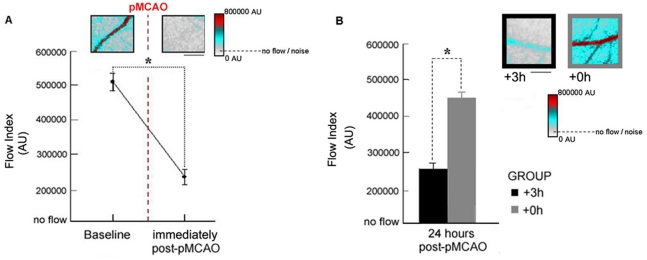
LSI experiments demonstrate that blood flow in MCA is re-established on the following day if whisker stimulation is administered immediately post-pMCAO.Insets, Representative linearly color scaled LSI images taken at (A) pre-pMCAO baseline and immediately post-pMCAO, or (B) 24 hours post-pMCAO for an animal from each of +0 h and +3 h groups. Scale bar indicates 0.25 mm. Graphs, the x-axis crosses the y at the mean noise level, or, ‘no flow’ level as determined by averaging values recorded from a group of euthanized animals (n = 6) at approximately 5 minutes after cessation of heart beat (MCA was thus no longer flowing in these animals hence the designation ‘no flow’ for equivalent values). To establish flow values in the absence of flow (noise) we collected data from a group of euthanized animals 5 minutes after the cessation of heart beat. We analyzed an MCA ROI as we had in live subjects and determined an average noise or ‘no-flow’ value (106,595±12,481SE). (A): Inset, note the large reduction in MCA flow. Graph, means and standard errors for MCA flow at pre-pMCAO baseline and immediately post-pMCAO. * indicates a significant difference between baseline and immediately post-pMCAO flow values (B): Inset, note the minimal blood flow apparent in the +3 h subject and the substantial blood flow in the +0 h subject despite the fact that the same double suture and complete transection of MCA's base was performed in both animals 24 hours prior. Graph, means and standard errors for MCA in +3 h and +0 h subjects 24 hours post-pMCAO. Note that the minimal flow values in +3 h group animals at 24 hours post-pMCAO are similar to levels seen immediately post-pMCAO in animals in panel A and that the flow values in +0 h animals are similar to baseline flow levels in panel A. * indicates a significant difference between +0 h and +3 h flow values at 24 hours post-pMCAO (*p = 0.000005). Note that pMCAO was performed by tightening two suture knots around the base of MCA and then completely transecting the artery between these two knots.